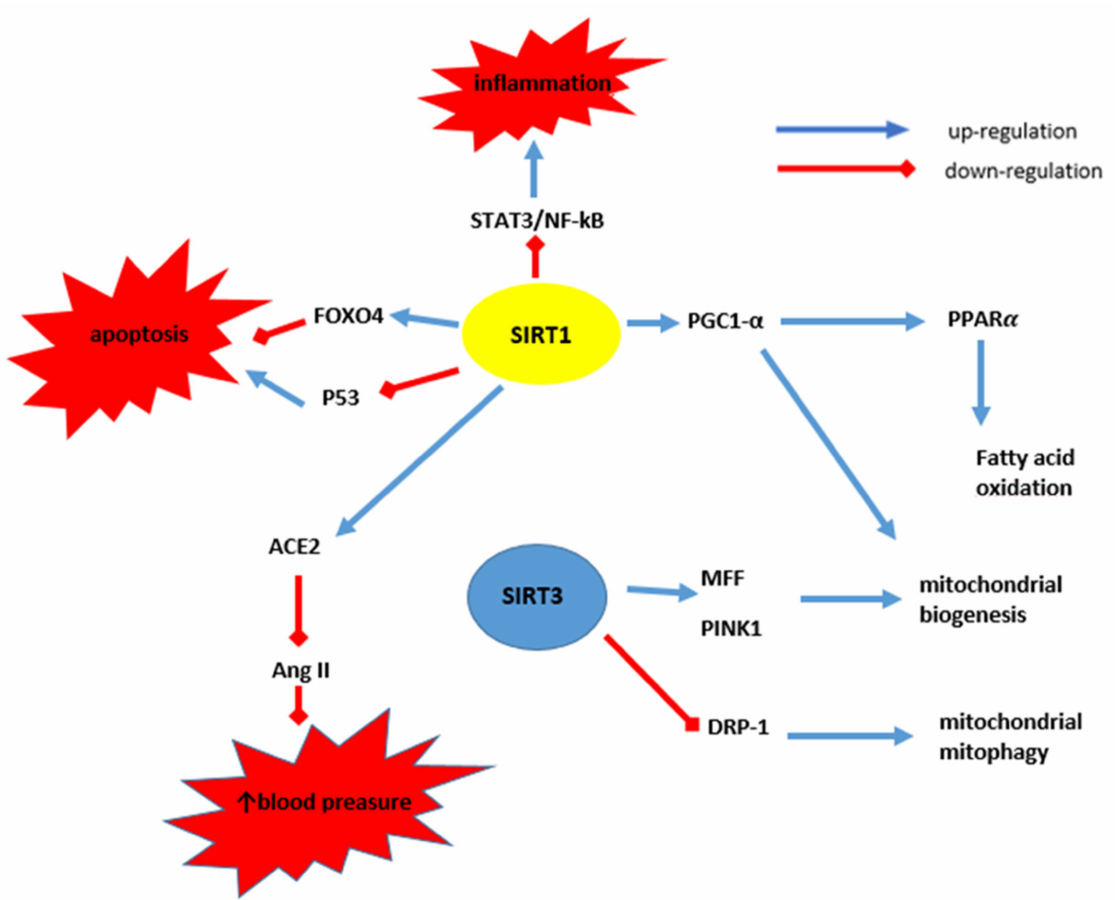
Figure 6. Scheme of connection between sirtuins, kidney disturbances and HIV infection. SIRT1 decreases the activity of NF- κ B, STAT3, FOXO4, p53 and PGC-1 α in podocytes, preventing excessive OS, inflammation and apoptosis. Deacetylation of PGC-1 α by SIRT1 increases its activity, promoting growth and division of mitochondria. PGC-1 α also activates PPAR α and regulates the processes of β -oxidation of fatty acids, affecting mitochondrial processes. SIRT1 binds to the promoter for angiotensin-converting enzyme 2 (ACE2) and increases its expression, promoting the conversion of Ang to AngII, and regulates the functioning of the RAS system with a positive effect on blood pressure and kidney function. Deacetylation of FOXO4 by SIRT1 prevents activation of BCL-2 gene transcription and the induction of apoptosis in podocytes and tubular cells. SIRT3 prevents mitophage processes and preserves mitochondria integrity by the down-regulation of DRP-1 and the up-regulation of MFF and PINK1. SIRT 1, 3, sirtuin 1, 3; FOXO4, forkhead box O4; NF- κ B, nuclear factor kappa-light- chain-enhancer of activated B cells; Ang II, angiotensin II; ACE2, angiotensin-converting enzyme 2; PPAR α , peroxisome proliferator-activated receptor alpha; PGC1- α , peroxisome proliferator-activated receptor gamma coactivator 1-alpha; STAT3, signal transducer and activator of transcription 3; MFF, mitochondrial fission factor; PINK1, PTEN-induced kinase 1; DRP-1, dynamin-related protein; OS, oxidative